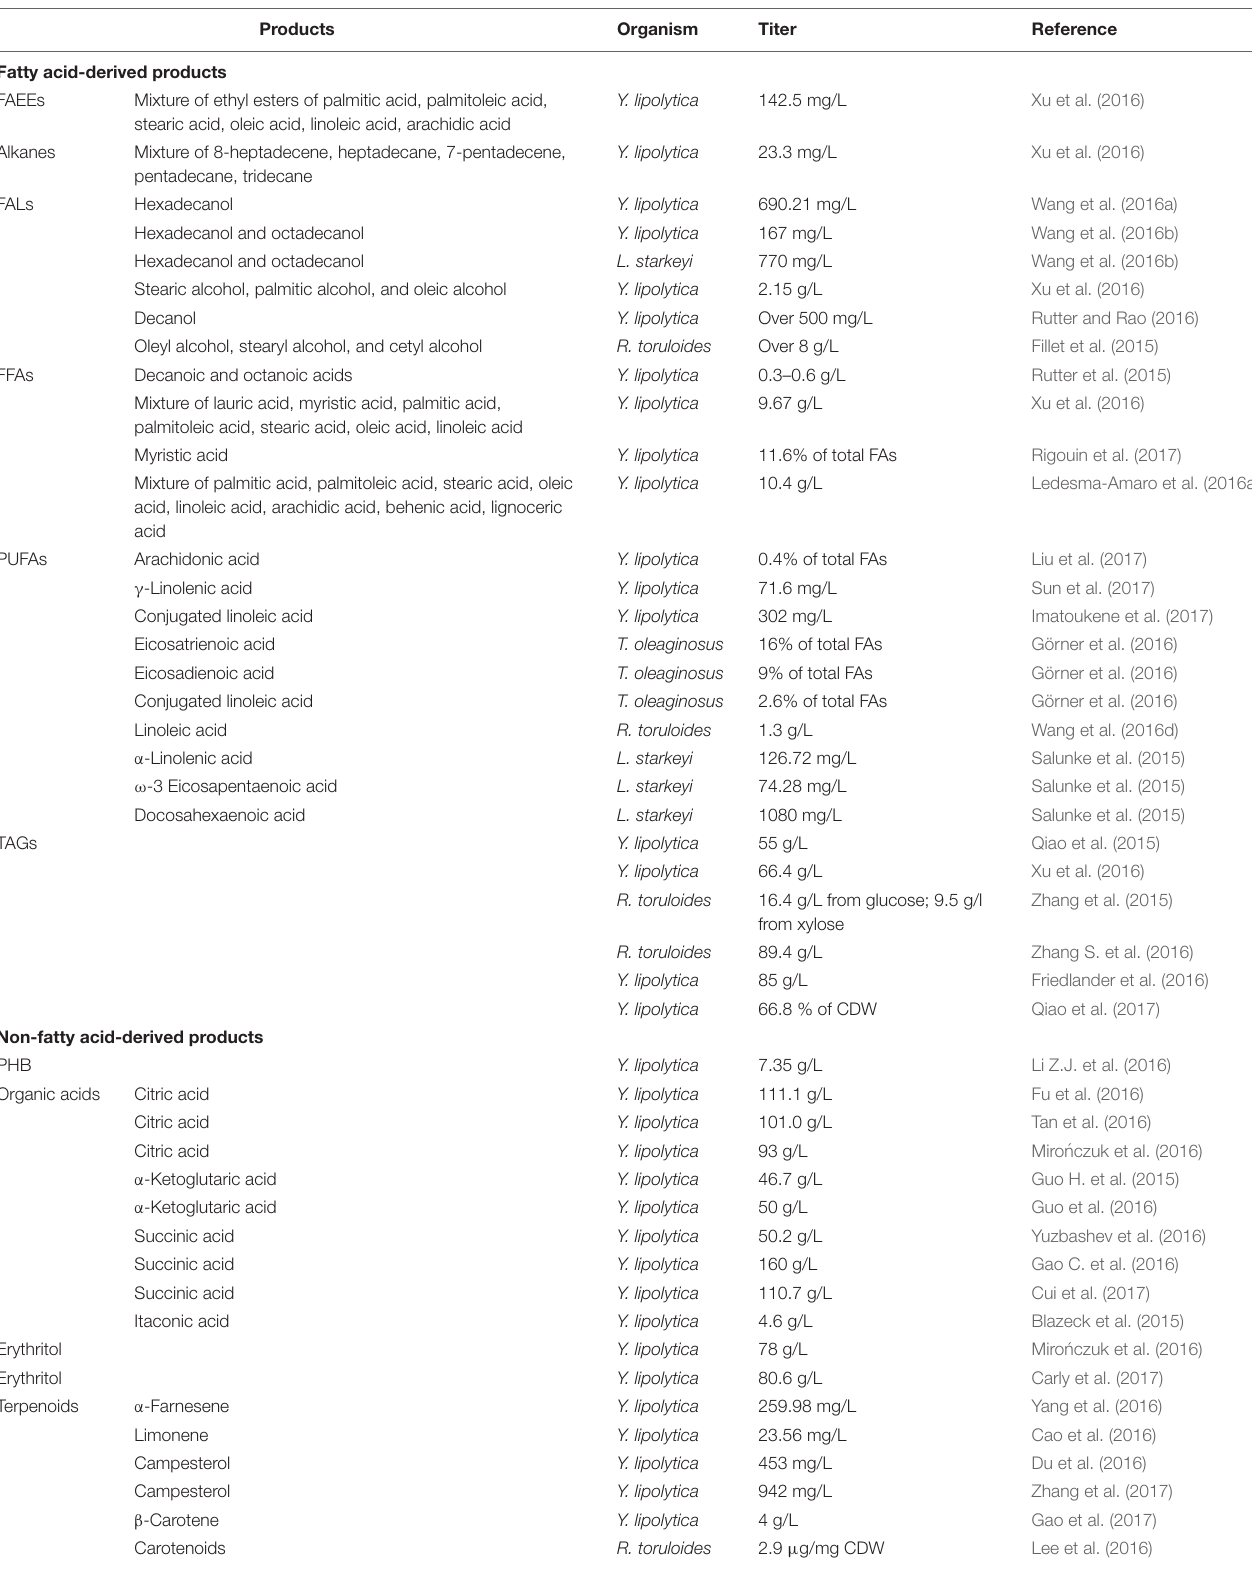
TABLE 1 | Examples of engineering oleaginous yeasts for producing a variety of different products in the recent 3 years (2015–2017). Products Organism